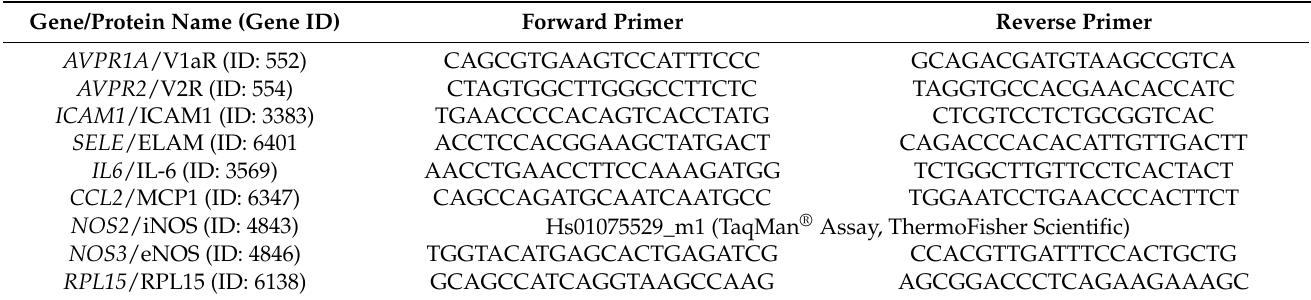
Table 1. Sequences of the primer pairs employed for RT-qPCR